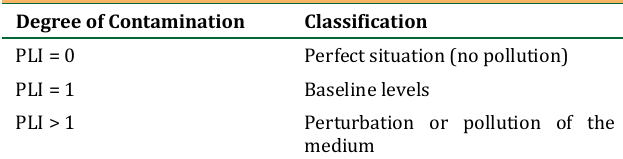
Table 6: Classification of pollution load index